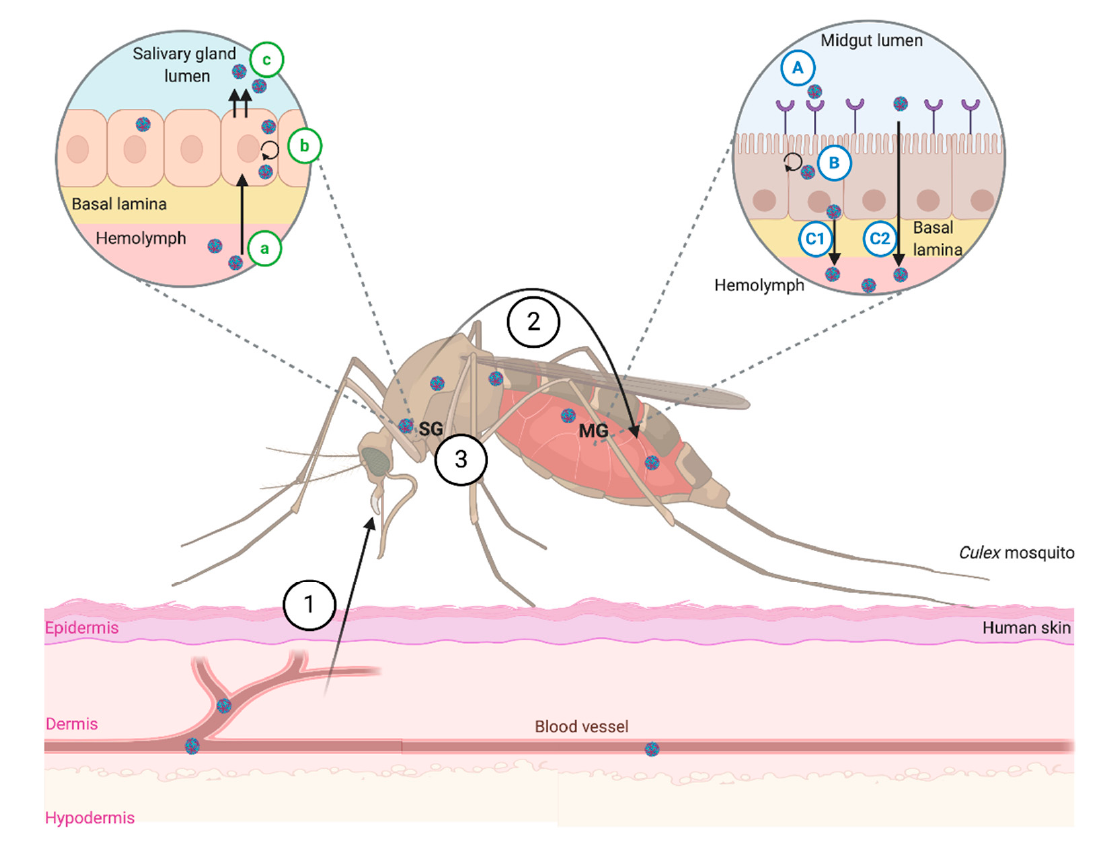
Figure 2. Dissemination steps of WNV in the invertebrate vector. ( 1 ) Mosquito feeds on virus-infected blood. ( 2 ) WNV infects mosquito midgut: ( A )—Virus binds to epithelial cells by a protein receptor. ( B )—Viral replication in midgut cells. ( C1 )—Direct passage from basal lamina to hemolymph (1st way). ( C2 )—Direct paracellular passage through midgut cells (2nd way). ( 3 ) Dissemination of WNV to other organs like salivary glands: ( a )—Infection of epithelial cells by direct passage from hemolymph to cells. ( b )—Viral replication in epithelial cells. ( c )—Release of virus from cells to salivary gland lumen, with or without apoptosis of epithelial cells (inspired by [68,69]).